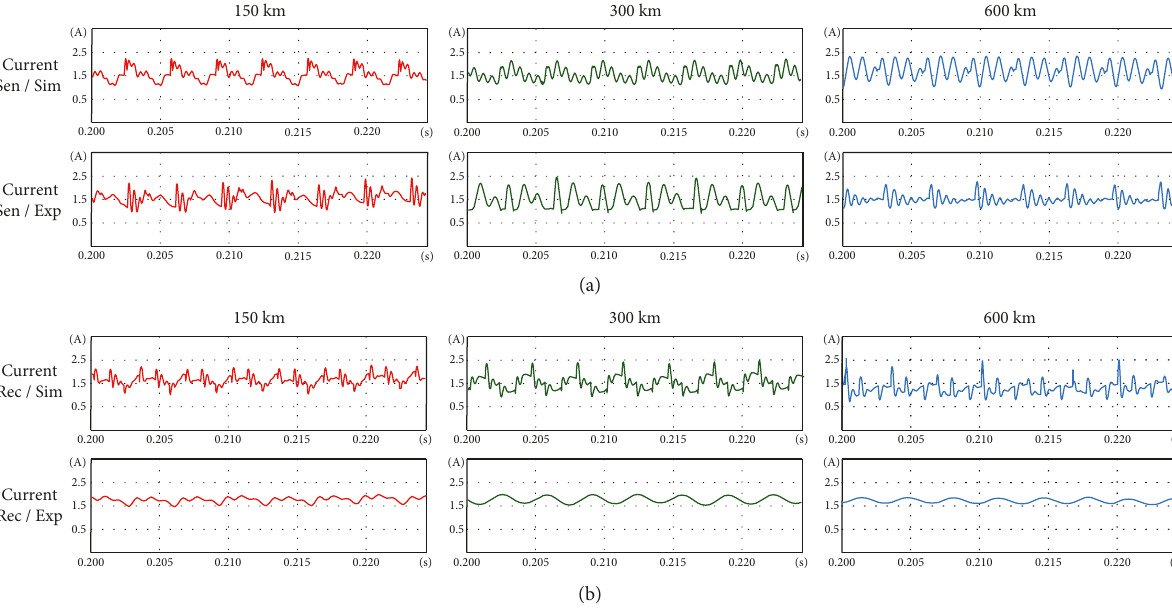
Figure 13: Comparison of the current waveforms based on the transmission line distance conditions. (a) Comparison of the sending side current waveforms and (b) comparison of the receiving side current